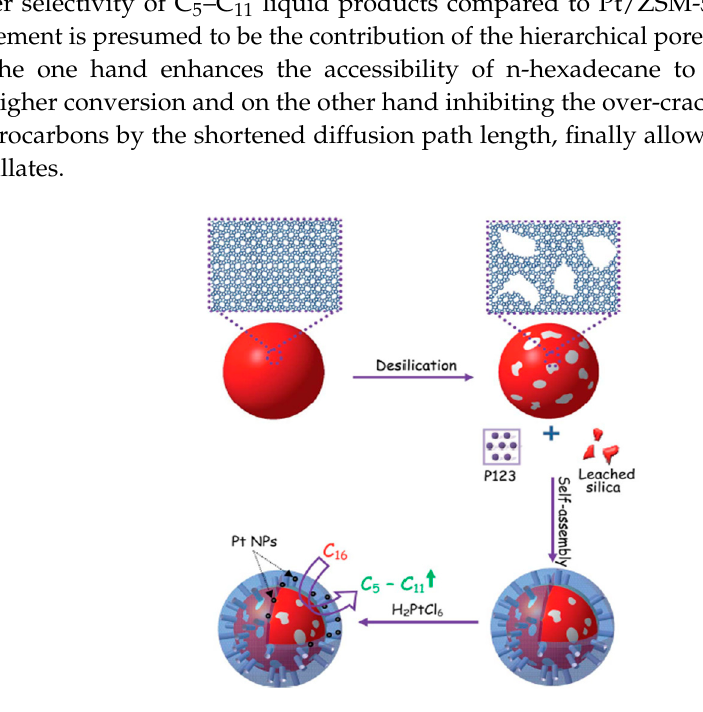
Figure 15. Schematic illustration of the synthesis of a novel HDS catalyst with PtMZ@MSA. Reproduced with permission from [68]. Copyright Royal Society of Chemistry, 2014.